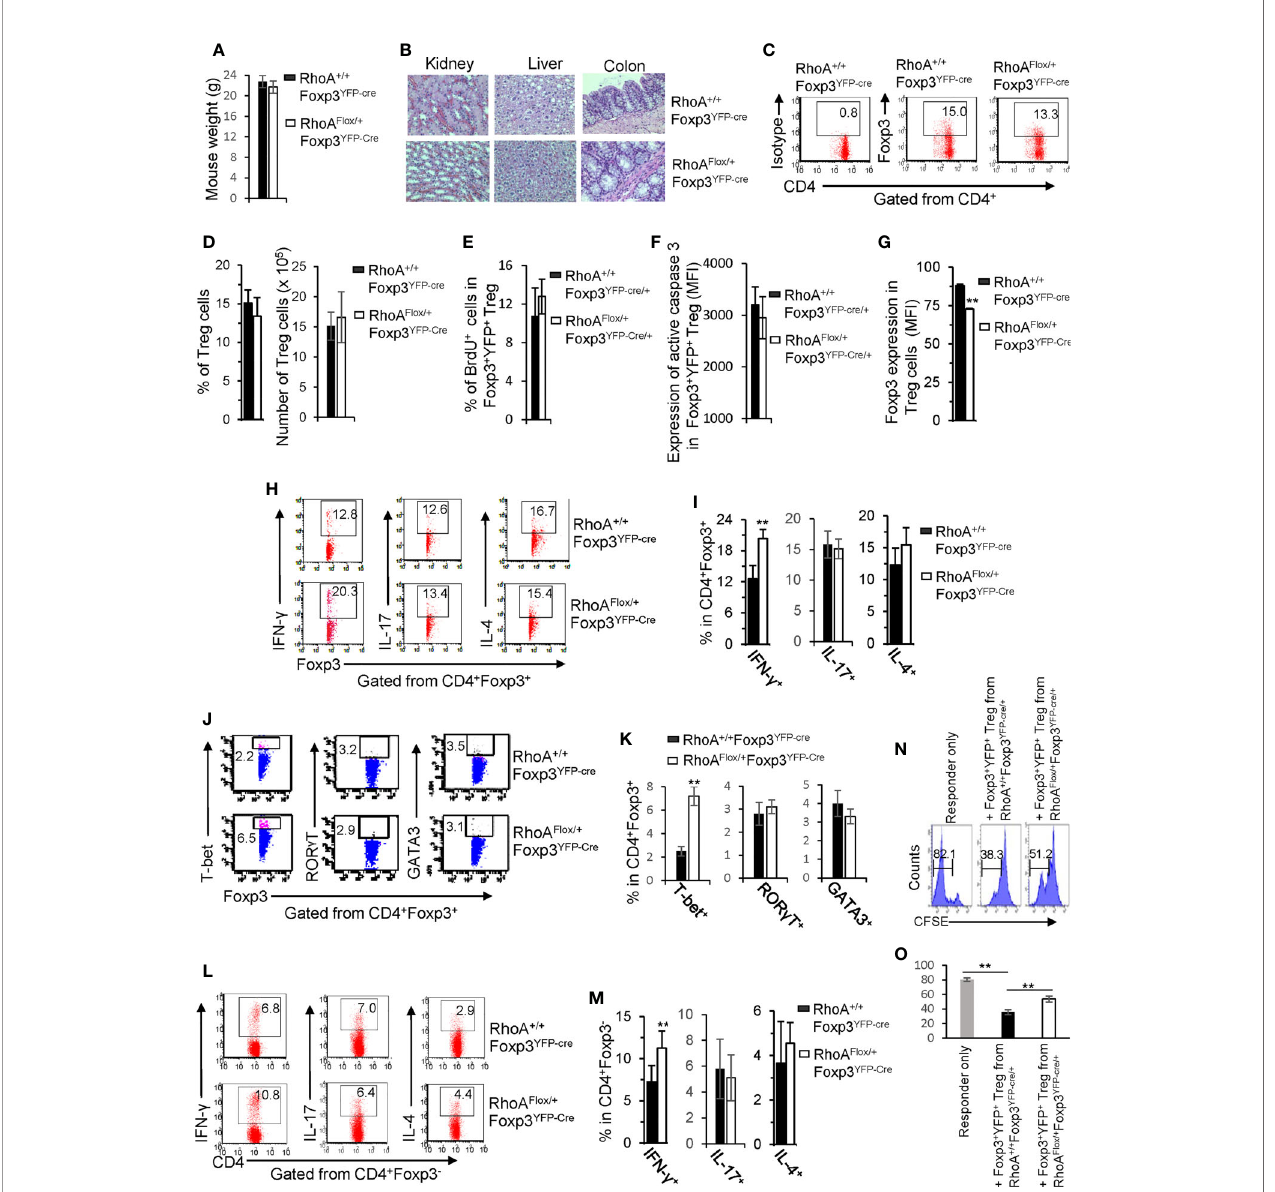
FIGURE 5 | Heterozygous RhoA deletion in Treg cells induces Treg cell plasticity and increases CD4 + effector T cells but does not result in autoimmunity. (A) Body weight of RhoA +/+ Foxp3 YFP-Cre and RhoA Flox/+ Foxp3 YFP-Cre mice. (B) Images of H&E staining of the indicated organs. (C) Representative fl ow cytogram of Foxp3 staining in CD4 + cells from the spleen of RhoA +/+ Foxp3 YFP-Cre and RhoA Flox/+ Foxp3 YFP-Cre mice. The numbers indicate percentages of CD4 + Foxp3 + Treg cells. (D) Left, average percentages of CD4 + Foxp3 + Treg cells. Right, cell numbers of CD4 + Foxp3 + Treg cells. (E) Proliferation of Foxp3 + YFP + Treg cells from RhoA +/+ Foxp3 YFP-Cre/+ and RhoA Flox/+ Foxp3 YFP-Cre/+ female mice. Percentages of Foxp3 + YFP + Treg cells incorporated with BrdU are shown. (F) Apoptosis of Foxp3 + YFP + Treg cells from RhoA +/+ Foxp3 YFP-Cre/+ and RhoA Flox/+ Foxp3 YFP-Cre/+ female mice. The expression levels (MFI: mean fl uorescence intensity) of active caspase 3 in Foxp3 + YFP + Treg cells are shown. (G) The expression levels of Foxp3 in Treg cells from RhoA +/+ Foxp3 YFP-Cre and RhoA Flox/+ Foxp3 YFP-Cre mice. (H) Representative fl ow cytogram of IFN- g , IL-17 and IL-4 staining in CD4 + Foxp3 + Treg cells. The numbers indicate percentages of IFN- g + , IL-17 + and IL-4 + Treg cells. (I) Average percentages of IFN- g + , IL-17 + and IL-4 + Treg cells. (J) Representative fl ow cytogram of ROR g T, T-bet and GATA3 staining in CD4 + Foxp3 + Treg cells. The numbers indicate percentages of ROR g T + , T-bet + , and GATA3 + Treg cells. (K) Average percentages of ROR g T + , T-bet + , and GATA3 + Treg cells. (L) Representative fl ow cytogram of IFN- g , IL-17 and IL-4 staining in CD4 + Foxp3 - cells. The numbers indicate percentages of IFN- g + CD4 + , IL-17 + CD4 + and IL-4 + CD4 + effector T cells. (M) Average percentages of IFN- g + CD4 + , IL-17 + CD4 + and IL-4 + CD4 + effector T cells. (N, O) In vitro Treg suppressive activity. (N) , representative fl ow cytogram of CFSE dilution in T cells (responder). The numbers above the gating are percentages of cells low for CFSE, representing proliferating T cells. (O) , average percentages of cells low for CFSE. Foxp3 + YFP + Treg cells were obtained by fl ow cytometry sorting of CD4 + YFP + cells from the spleen of RhoA +/+ Foxp3 YFP-Cre/+ and RhoA Flox/+ Foxp3 YFP-Cre/+ female mice. (A, C – O) Error bars indicate SD of 5-6 mice (A, C – M) or triplicates (N, O) . Data are representative of two independent experiments. Error bars indicate SD. **p < 0.01. (B) Data are representative of 3